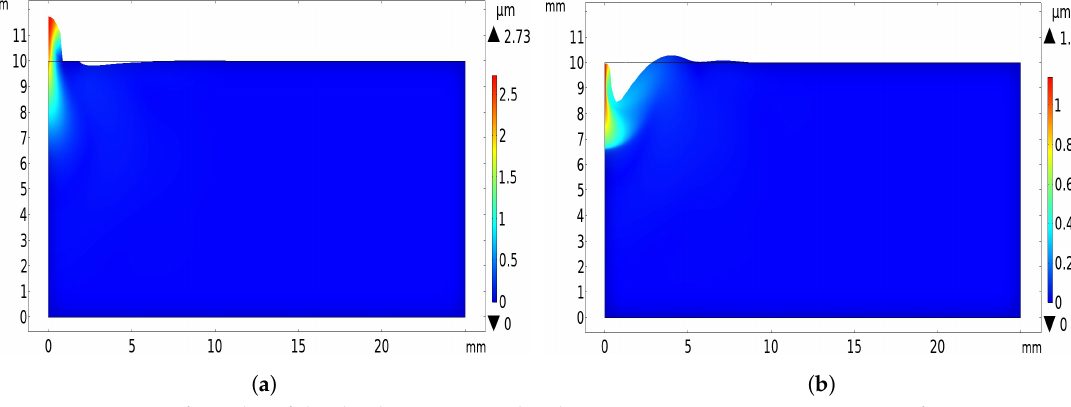
Figure 13. Surface plot of the displacement amplitude z -component in 500 Hz excitation frequency in the two boundary conditions; ( a ) connected pipette; ( b ) pipette with